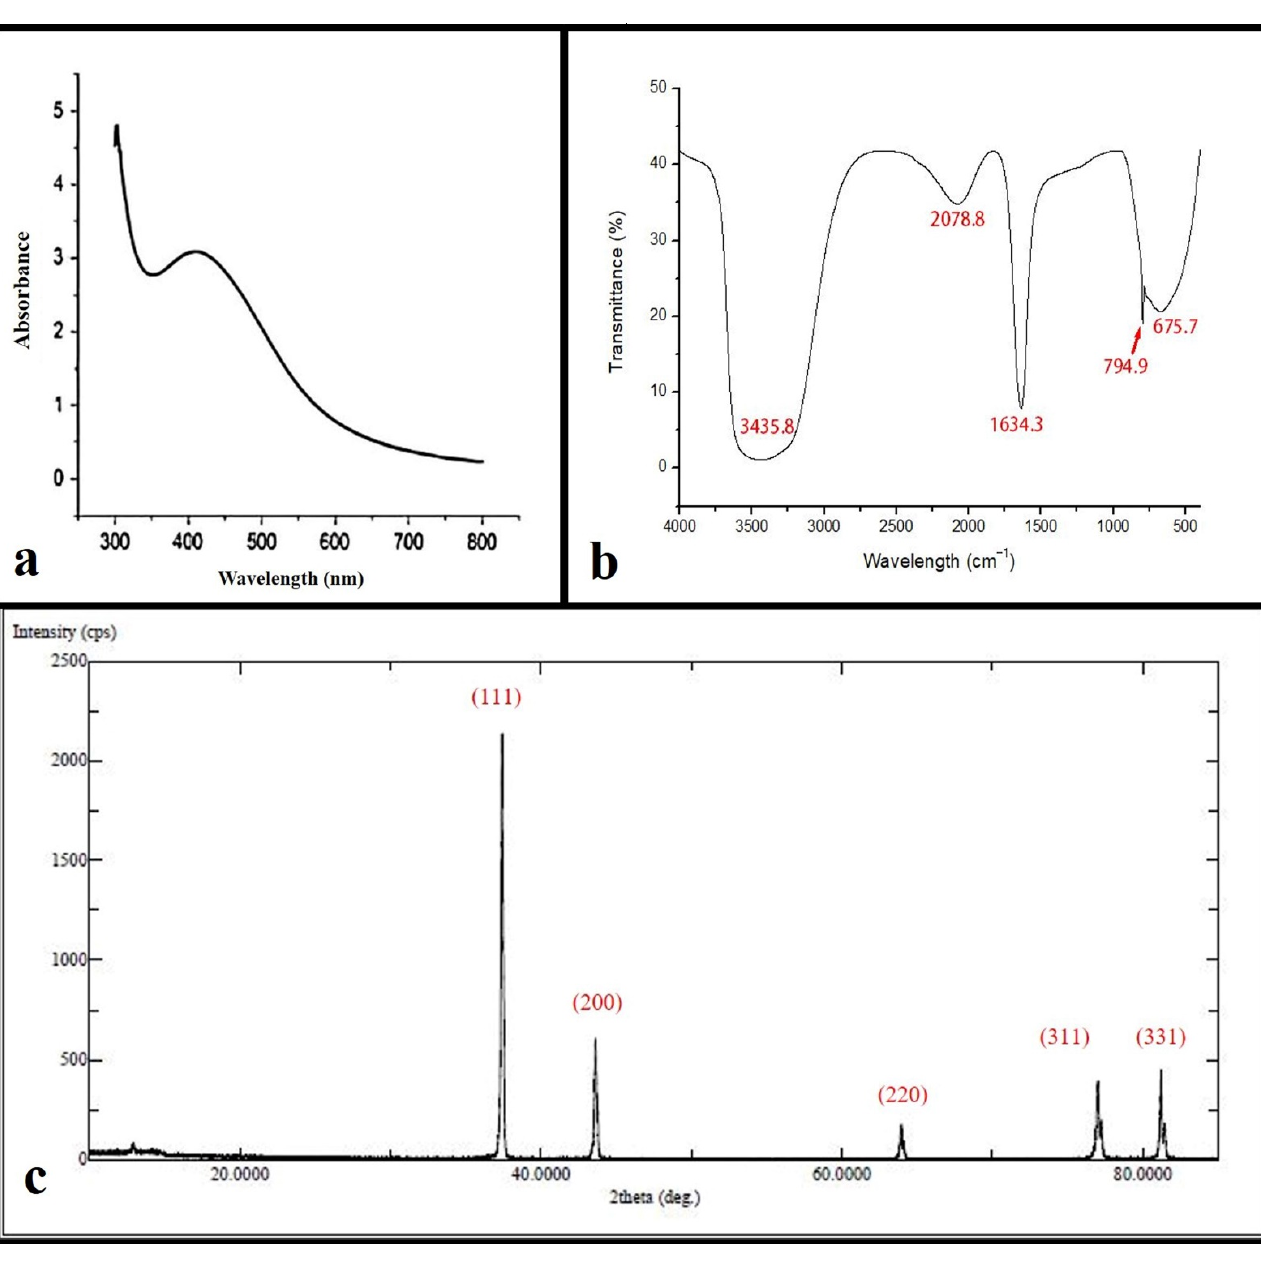
Figure 1. Ultraviolet-visible absorption spectrum of the silver nanoparticles (AgNPs) with a plas- mon band at 400 nm ( a ). FT-IR spectrum of synthesized AgNPs ( b ). XRD patterns ( c